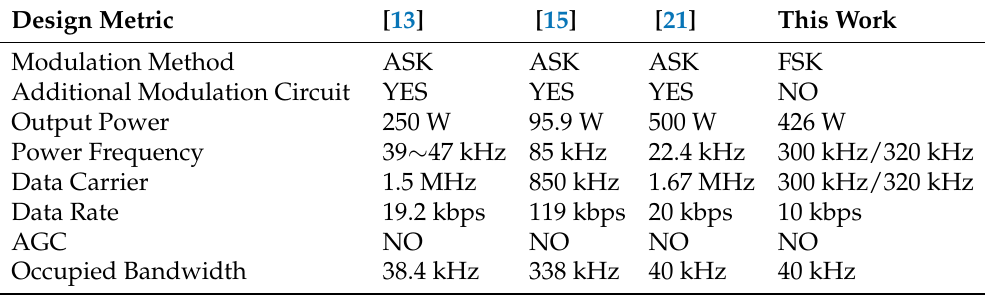
Table 2. Performance of the existing